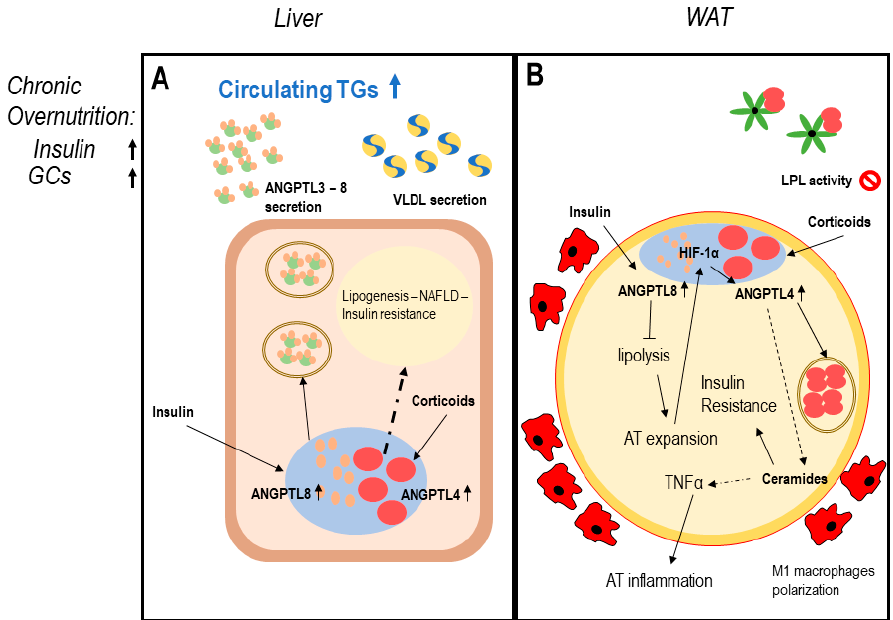
Figure 2. ANGPTLs model of adipose tissue dysfunction. Legend: possible induction mechanism of adipose tissue dysfunction involving ANGPTL3-4-8. Dotted lines report data with a low level of evidence. Panel ( A ) describes dysregulation of hepatocytes function in conditions of chronic overnutrition: overexpressed insulin levels together with elevated plasma glucocorticoids in obese patients induce both ANGPTL8 and ANGPTL4 expression in hepatocytes [68,73–75,84,86,89,94]. ANGPTL4 possibly induces ceramides production; therefore, worsening hepatic insulin resistance and liver steatosis [35,81,89]. Panel ( B ) describes white adipose tissue (WAT) dysfunction in conditions of chronic overnutrition, potentially mediated by ANGPTLs system disruption: excess insulin induces overexpression of nuclear ANGPTL8 in WAT [67,68]. ANGPTL8 in turn enhances insulin signaling via AKT phosphorylation, chronic AKT phosphorylation induces worsening